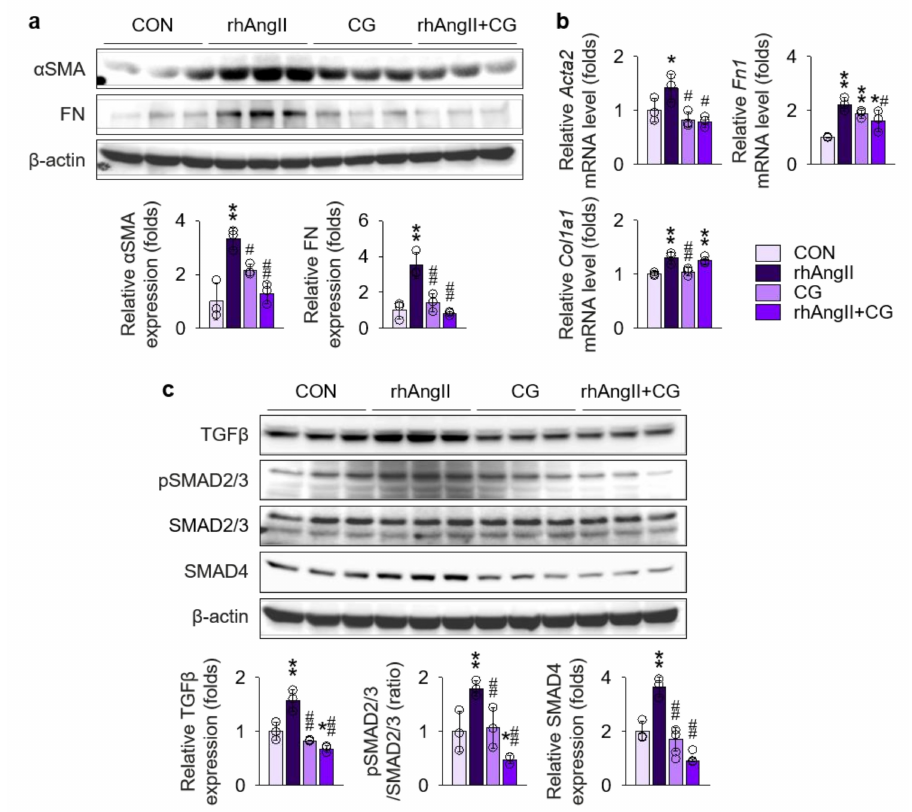
Figure 8. CG directly targeted activation of TGF β signals in Ang II-stimulated NRK-49F cells. ( a ) Comparison of protein expression level for TGF β and its downstream molecules in NRK-49F after stimulation with vehicles or recombinant human Ang II (rhAng II) with or without co-treatment of CG ( n = 3 / group). β -actin was used as the endogenous control. Data are representative more than three independent experiments. ( b , c ) Comparison of expression level for fibrosis markers determined by immunoblotting ( b ) and qPCR ( c ) in NRK-49F after stimulation with vehicles or recombinant human Ang II (rhAng II) with or without co-treatment of CG ( n = 3 / group). β -actin for immunoblotting and GAPDH for qPCR were used as the endogenous controls, respectively. * p < 0.05, ** p < 0.01 vs. control cells (CON); # p < 0.05, ## p < 0.01 vs. rhAng II-treated cells by one-way ANOVA with Newman–Keuls multiple comparison